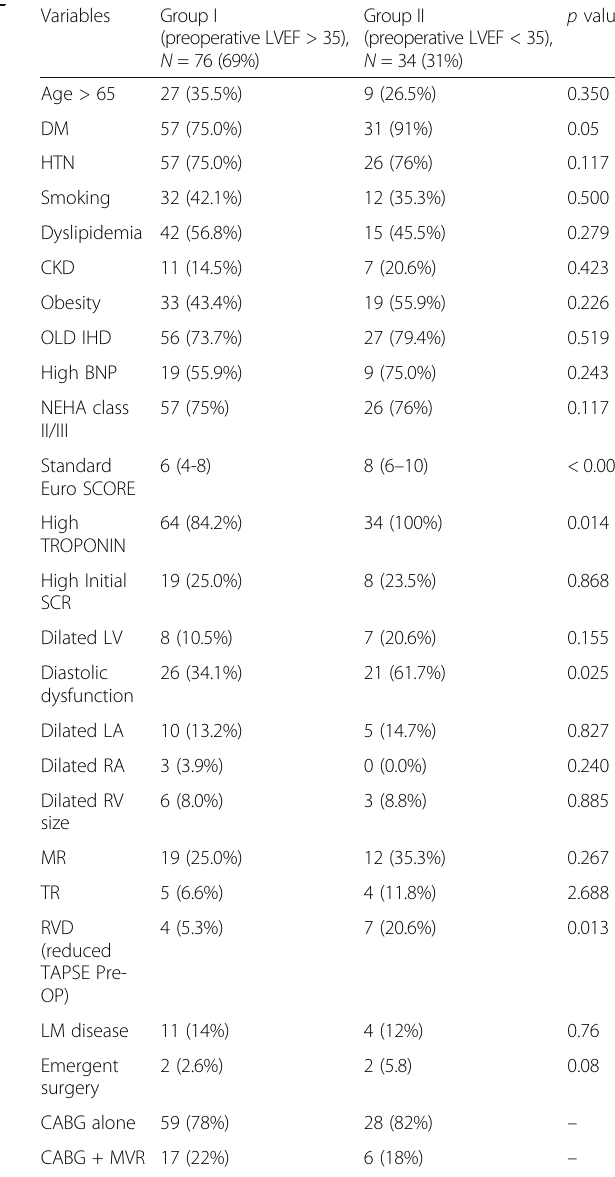
Table 1 Demographics and clinical and operative data Table 2 Comparison of demographic and clinical data between the two